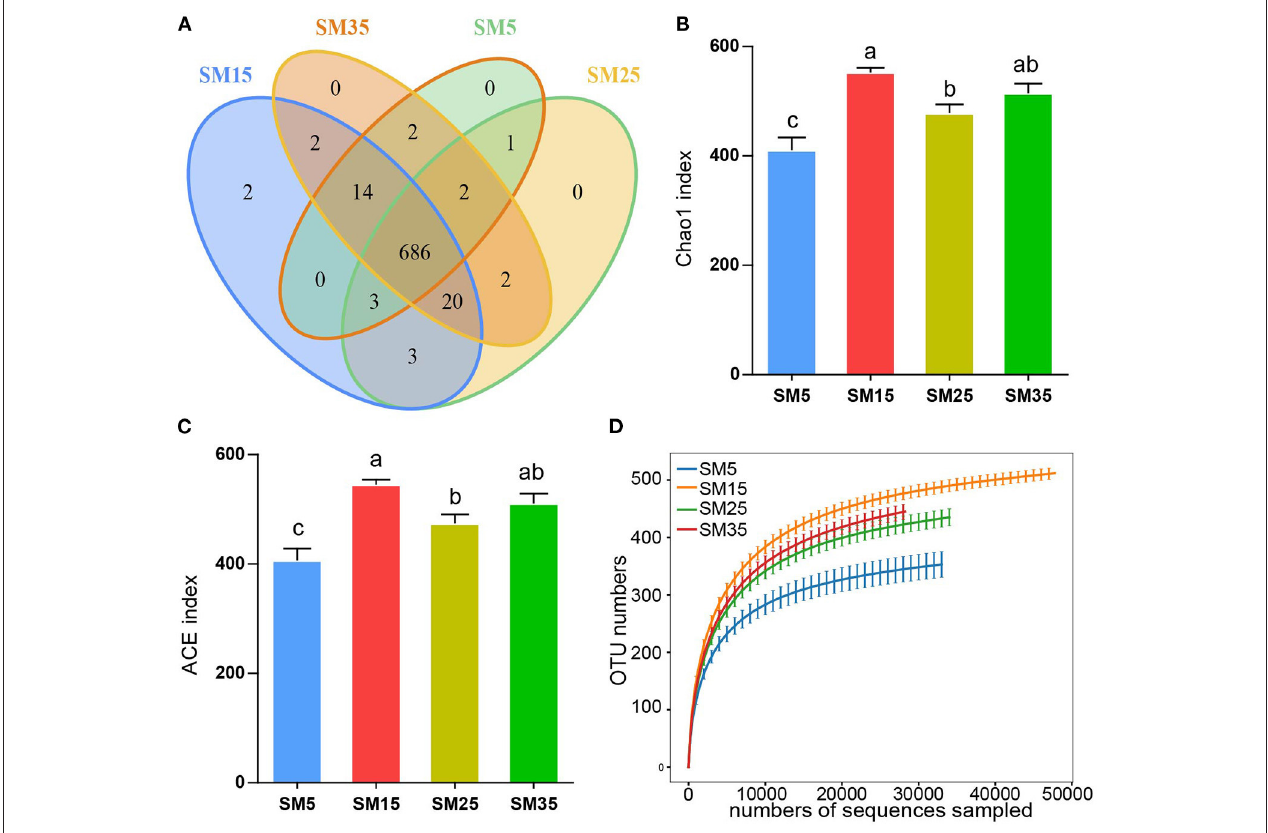
FIGURE 1 | Structure of phyllosphere bacterial communities of Chinese fir in stands of different ages. (A) Venn diagram of phyllosphere bacterial operational taxonomic units (OTUs); (B) ACE index for each stand age; (C) Chaos index for each stand age; (D) Rarefaction curve of number of OTUs with increasing sequencing depth. SM5, SM15, SM25, and SM35 represent stands of age 5, 15, 25, and 35 years, respectively ( n = 18).